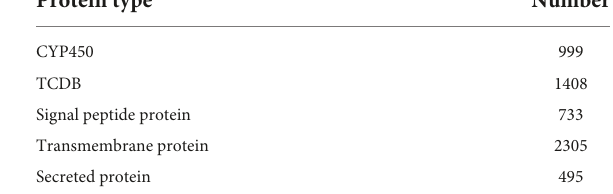
TABLE 3 Statistical table of protein structure prediction.